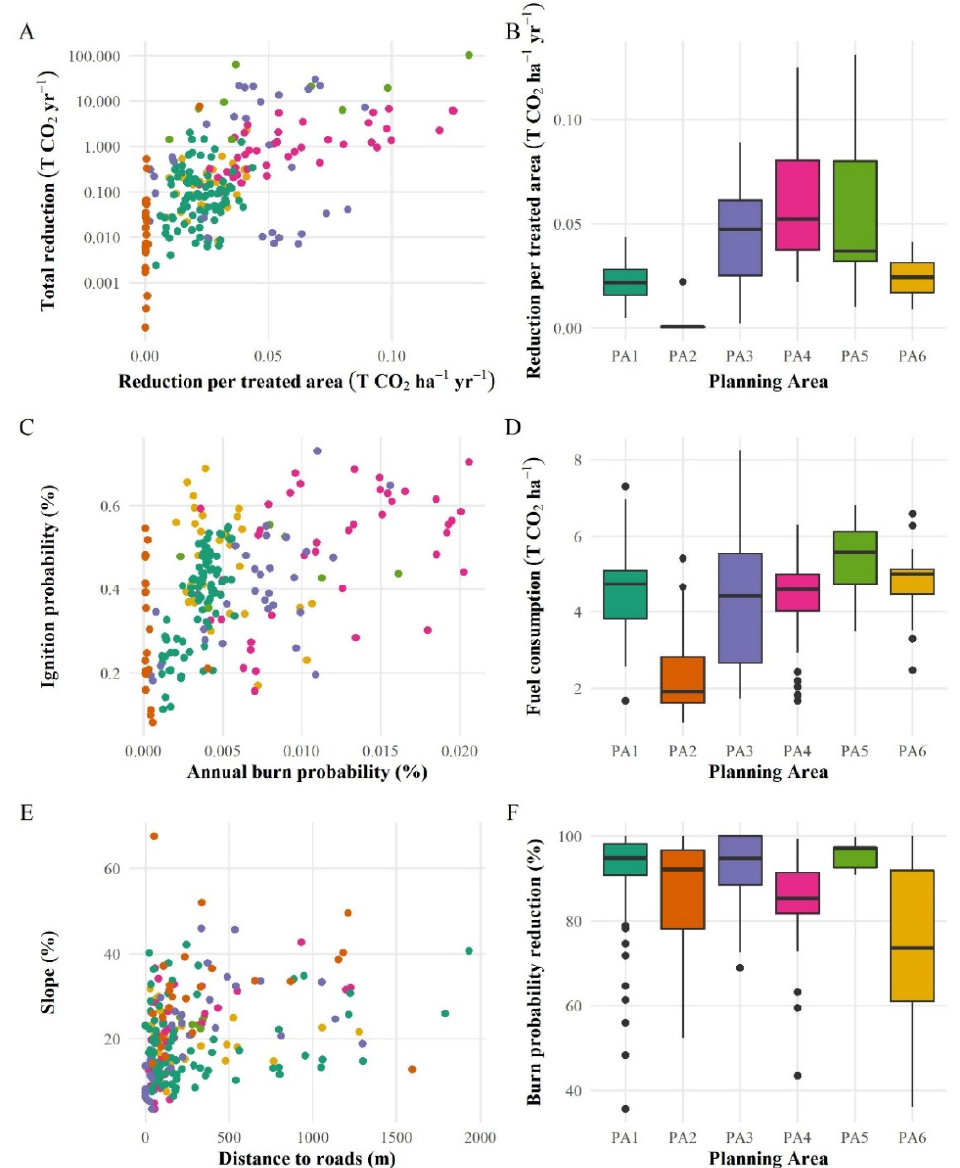
Figure 7. Summary statistics for the strategic management points. The performance is shown by treatment unit ( A ) and planning area ( B ) level. We obtained treatment unit-level wildfire occurrence and wildfire likelihood ( C ). The conditional fuel consumption is presented by planning area ( D ). Treatment implementation (Figure 2) operational constraints in terms of the average slope and distance to rode are presented by treatment unit ( E ). Finally, we show the burn probability reduction in treated SMP (Figure 6) by planning area ( F ). In box plots, the boxes indicate the first/third quartiles, the whiskers indicate 10th and 90th percentiles, the black line is the median, and the dots indicate values below the 10th percentile or above the 90th percentile. The colors refer to planning areas, as shown in